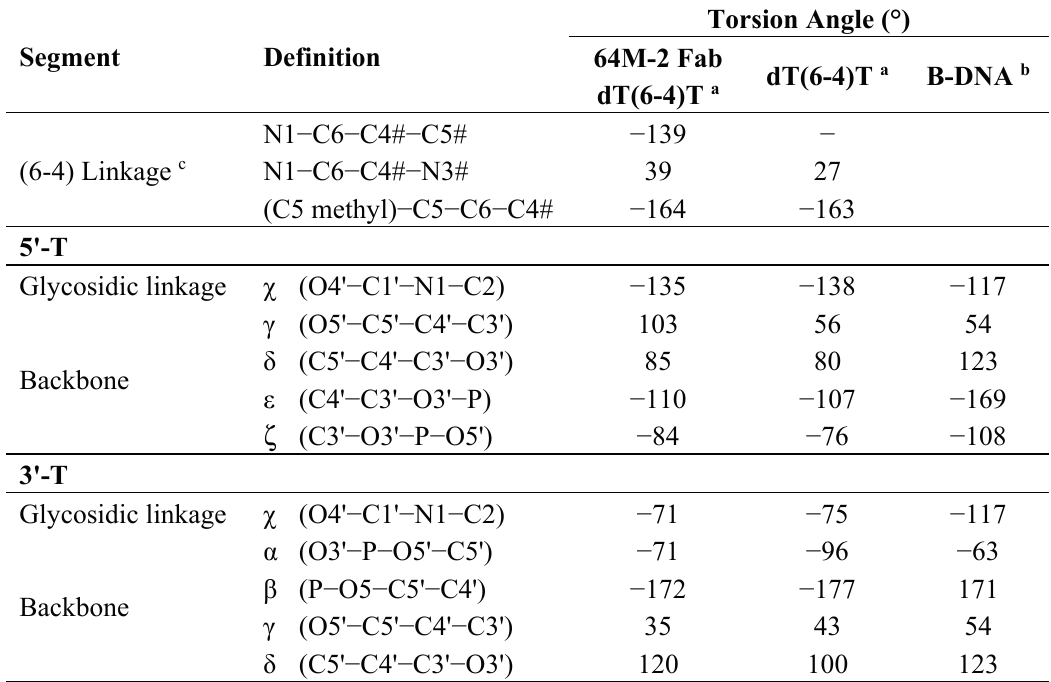
Table 1. DNA torsion